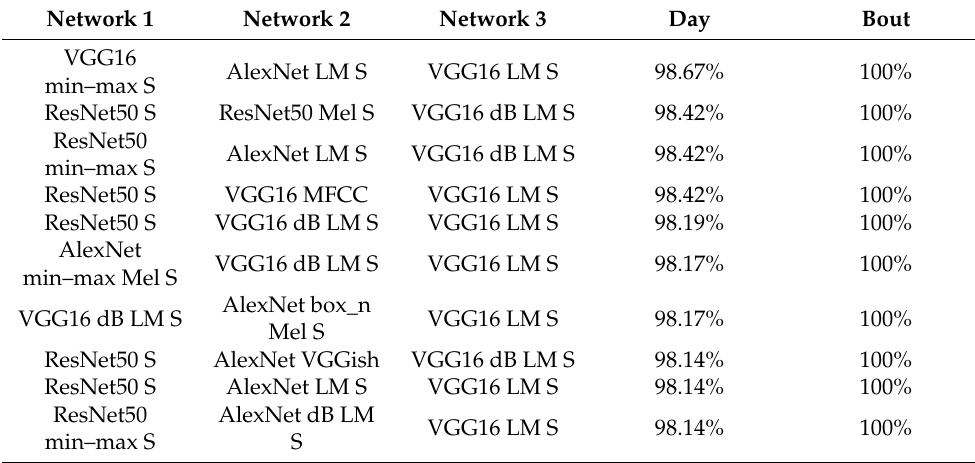
Table 3. Performance Accuracy of 3-Ensemble on the ERR Day and ERR Bout Datasets (sorted by